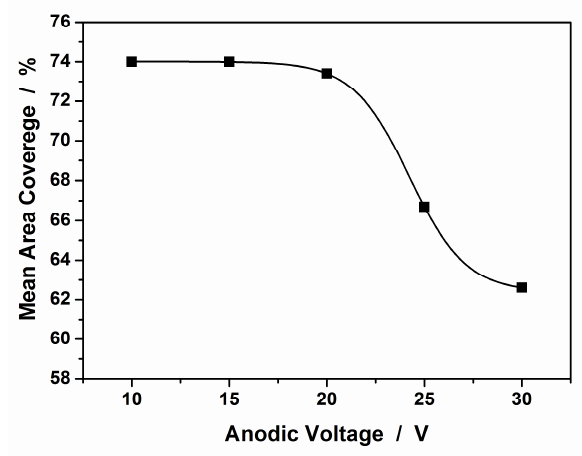
Figure 4. Scanning transmission electron microscopy (STEM) image of cubic silver nanoparticles